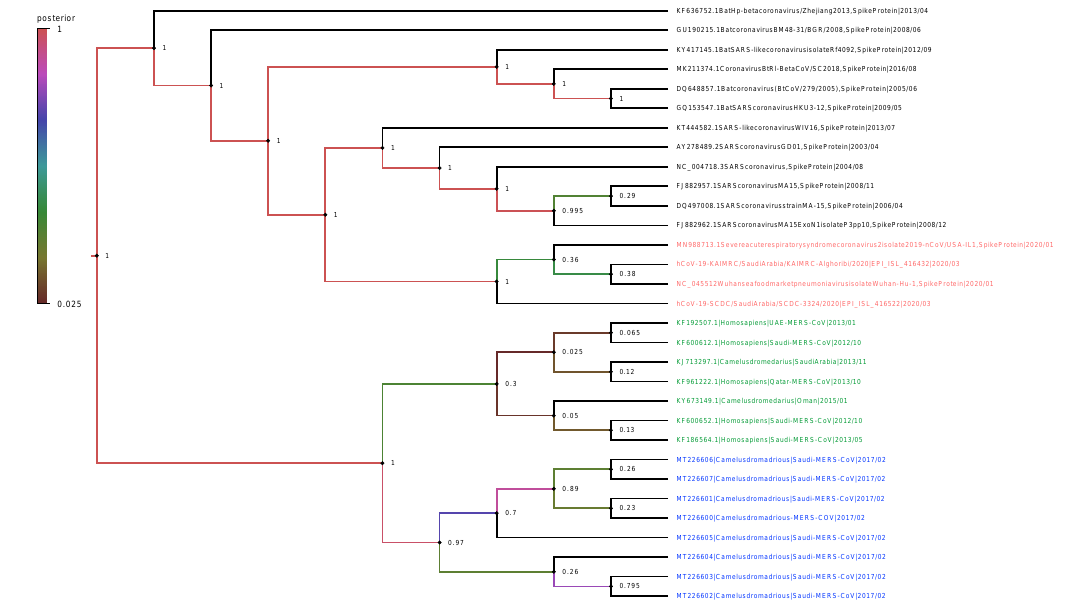
Figure 2. Phylogenetic analysis of spike proteins of our eight MERS-CoV isolates and representative viruses of the genus Betacoronavirus. The new eight isolates are in blue, other MERS-CoV strains in green, and 2019-nCoV in red. The numbers at nodes represent the posterior probabilities of their